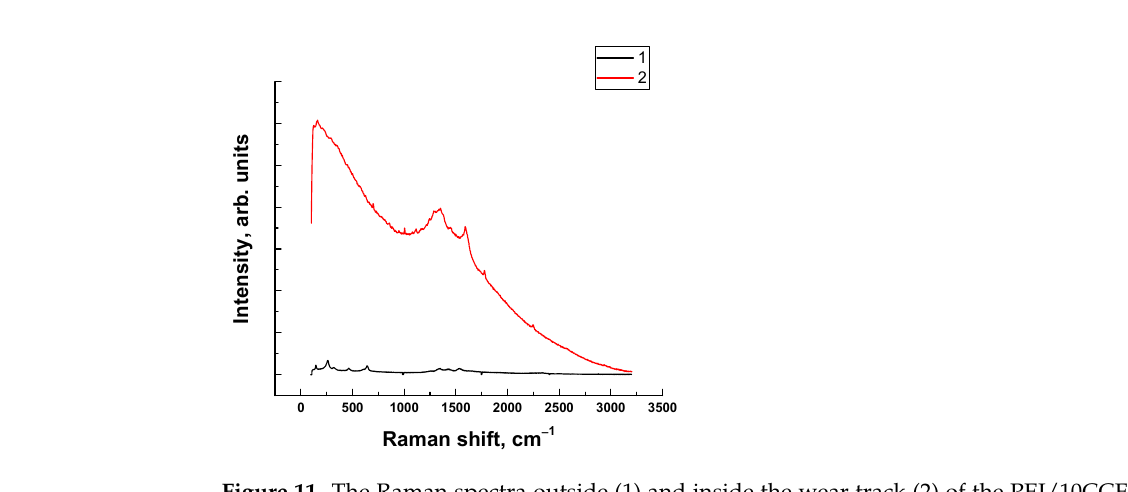
Figure 11. The Raman spectra outside (1) and inside the wear track (2) of the PEI/10CCF/1HNT nanocomposite. Linear tribological contact. P = 60 N, V = 0.3 m/s.